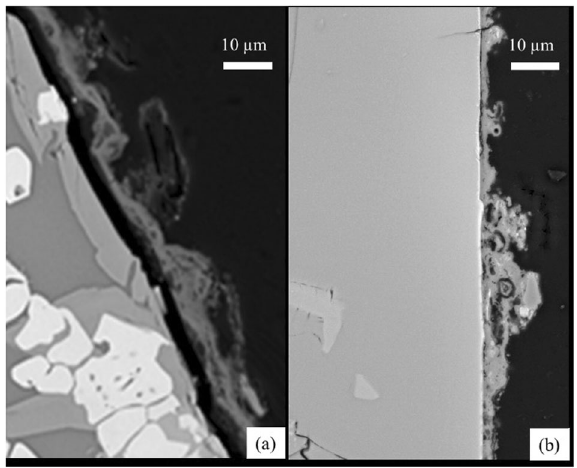
Fig. 8 A comparison of alteration features produced by exposure to the altering environment at Broborg. a Archeological glass samples BBlb ( b ) with alteration features produced by VHT for archeological glass sample